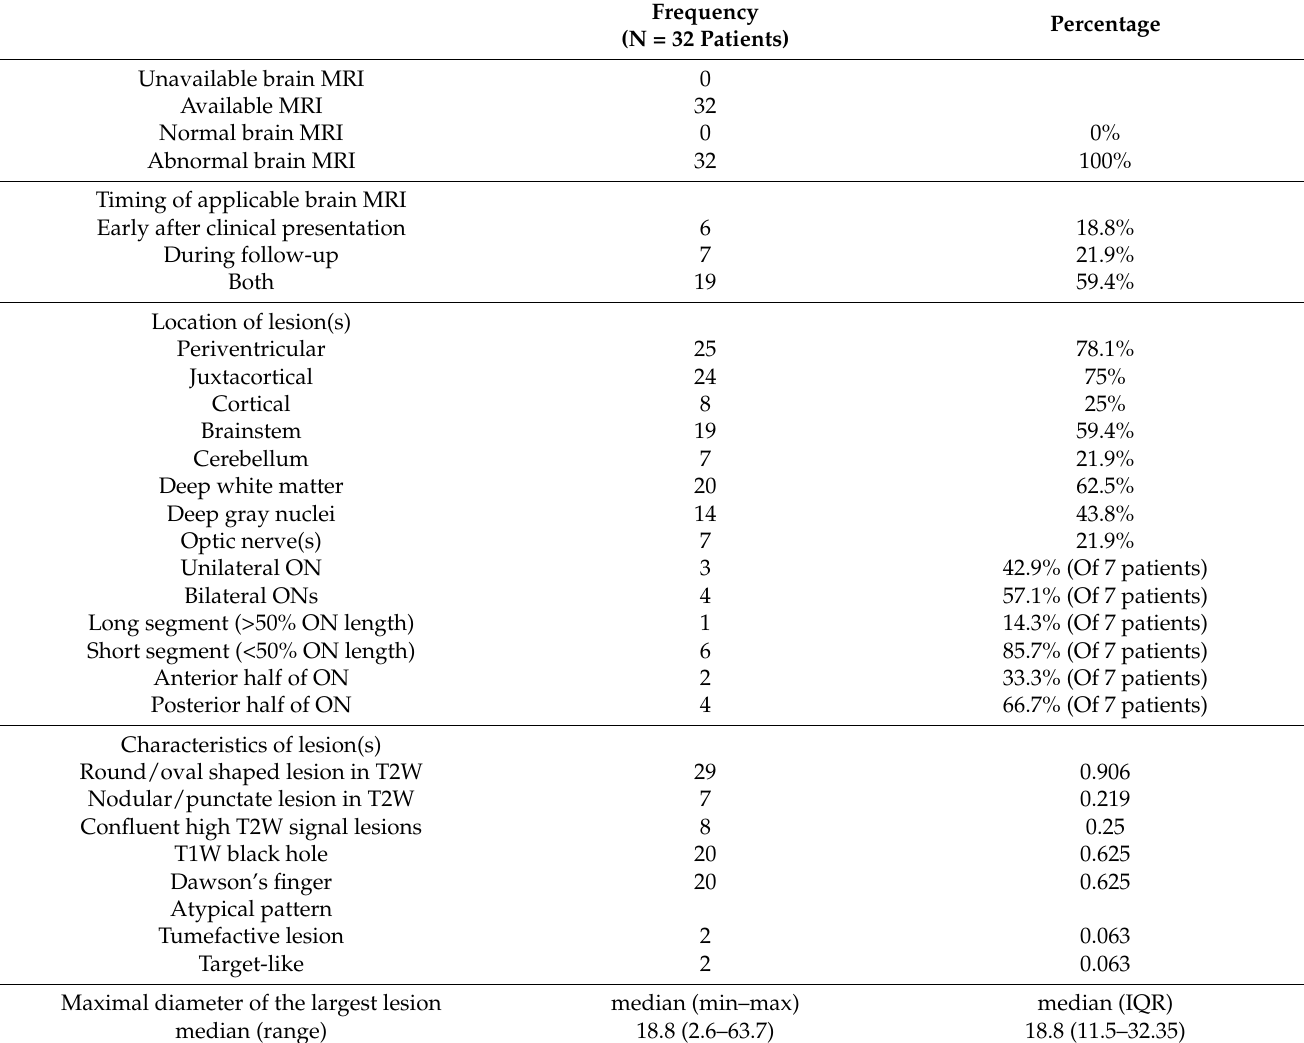
Figure 5. Axial T2W images of the same patient showing extensive hypersignal–intensity lesions scattered at juxtacortical region, subcortical region, deep white matter and periventricular white matter of bilateral cerebral hemispheres. Table 2. Brain MRI findings (brain MRIs were available for all 32 patients).